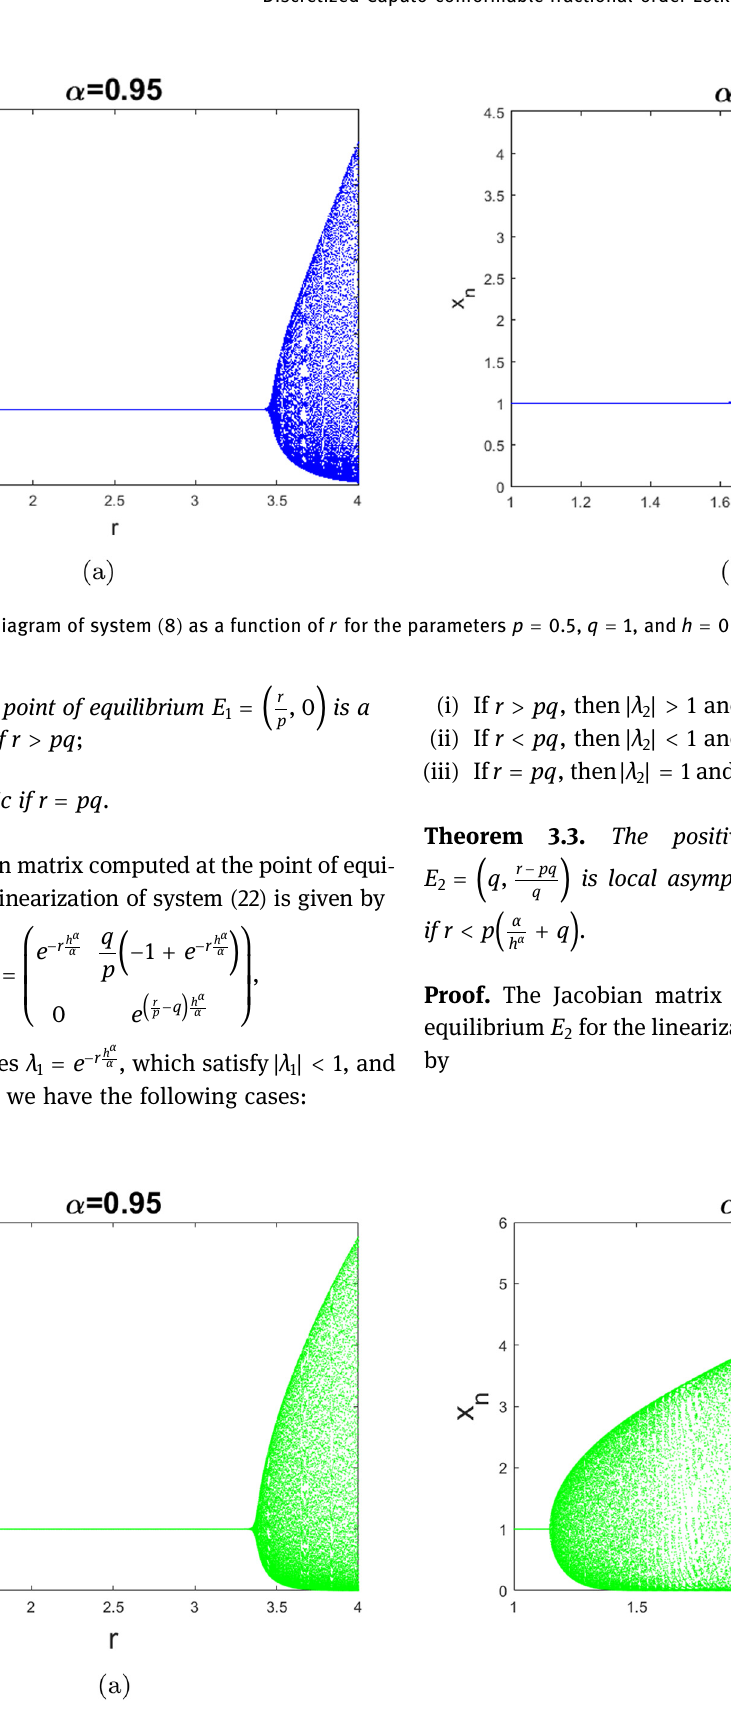
Figure 6: Bifurcation diagram of system ( 22 ) as a function of r for the parameters = = p q 0.5, 1 , and = h 0.15 : ( a ) = α 0.95 and ( b ) = α 0.5